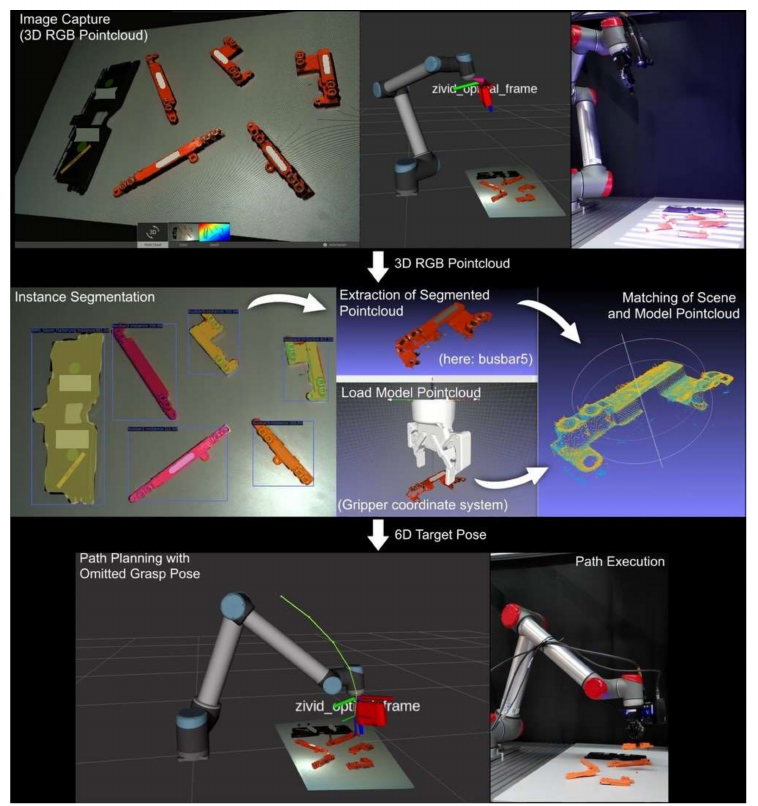
Figure 16. Overview of the full workflow from point cloud capture to path execution by the